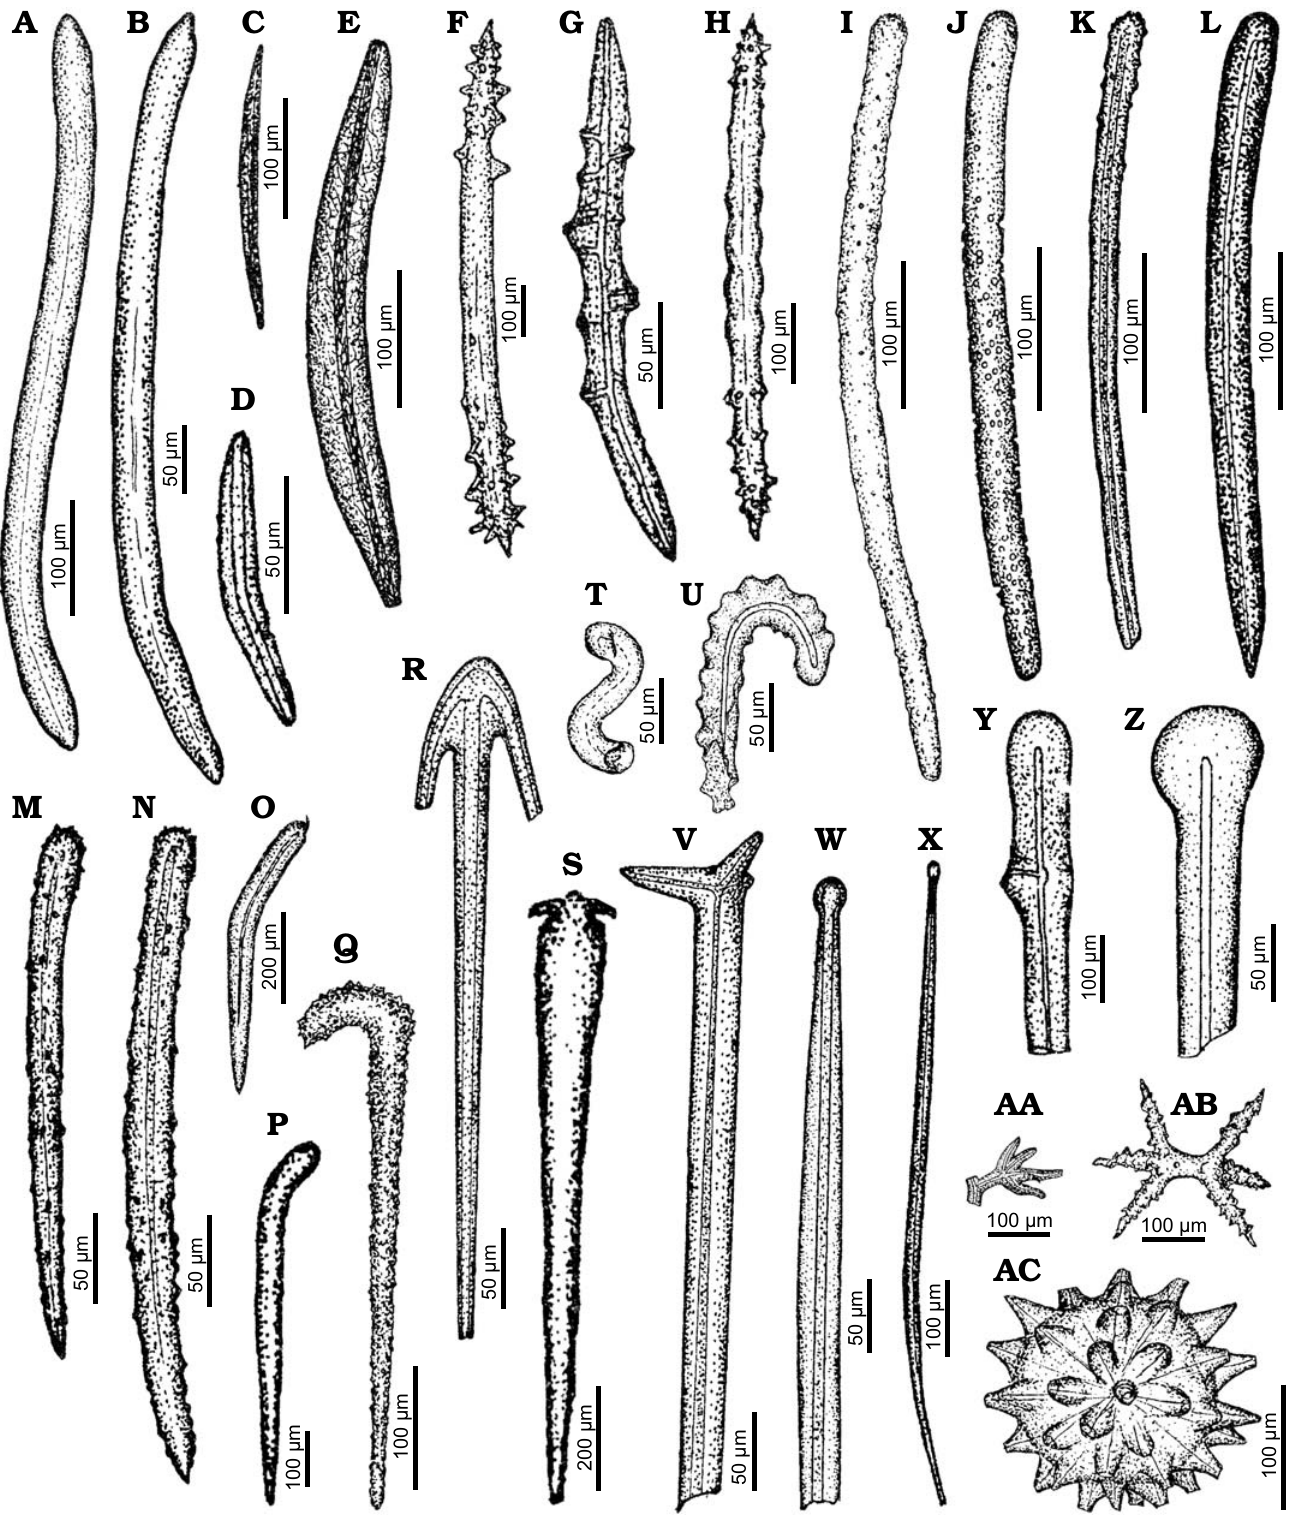
Fig. 7. Spicule morphotypes from south-central Ukraine; Markovka, upper Eocene (A, E, K), Kiselevka, middle Eocene (B, U), Lipcy, middle Eocene